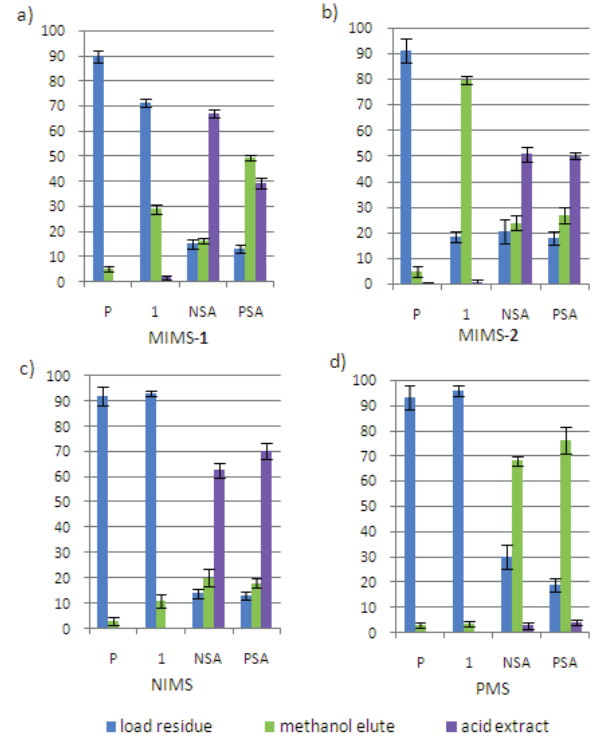
Figure 4: Solid phase extraction of a) MIMS- 1 , b) MIMS- 2 , c) NIMS and d) PMS for P , 1 , NSA and PSA